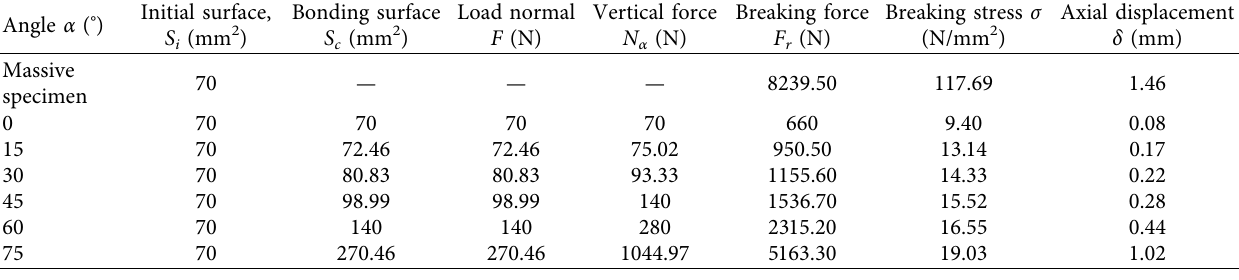
Table 3: Normal and vertical loads of the specimen ( P � 1 N/mm 2 ) and synthesis of experimental tests in axial traction by angle variation α . Initial surface, Angle α ( ° )